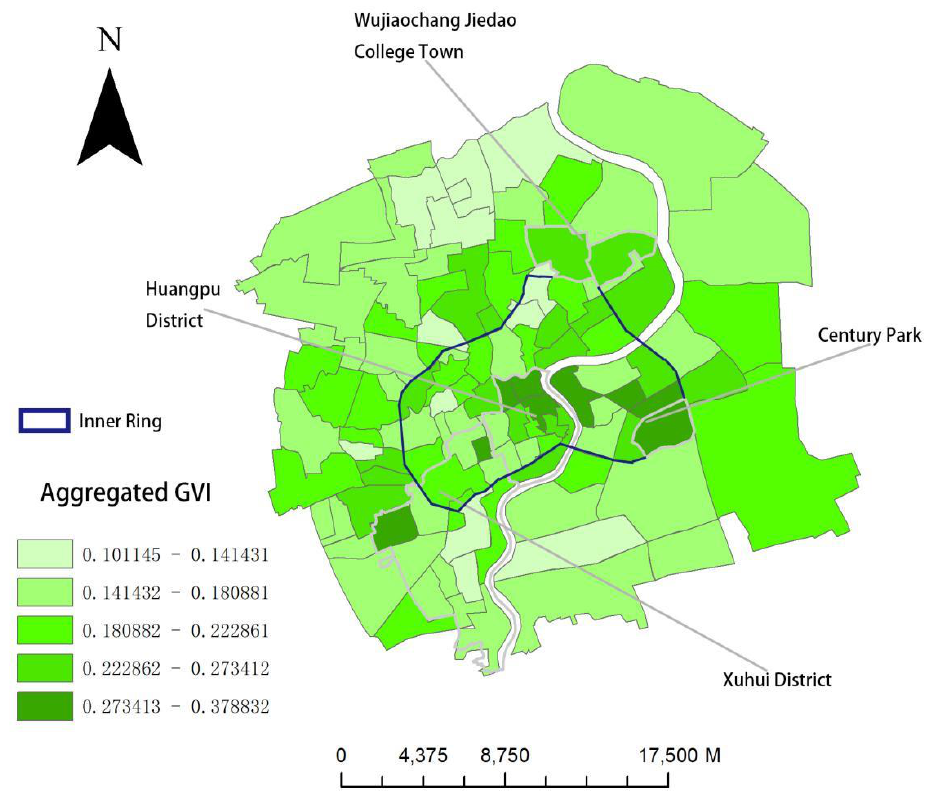
Figure 10. Aggregated green-view value at county or jiedao level.